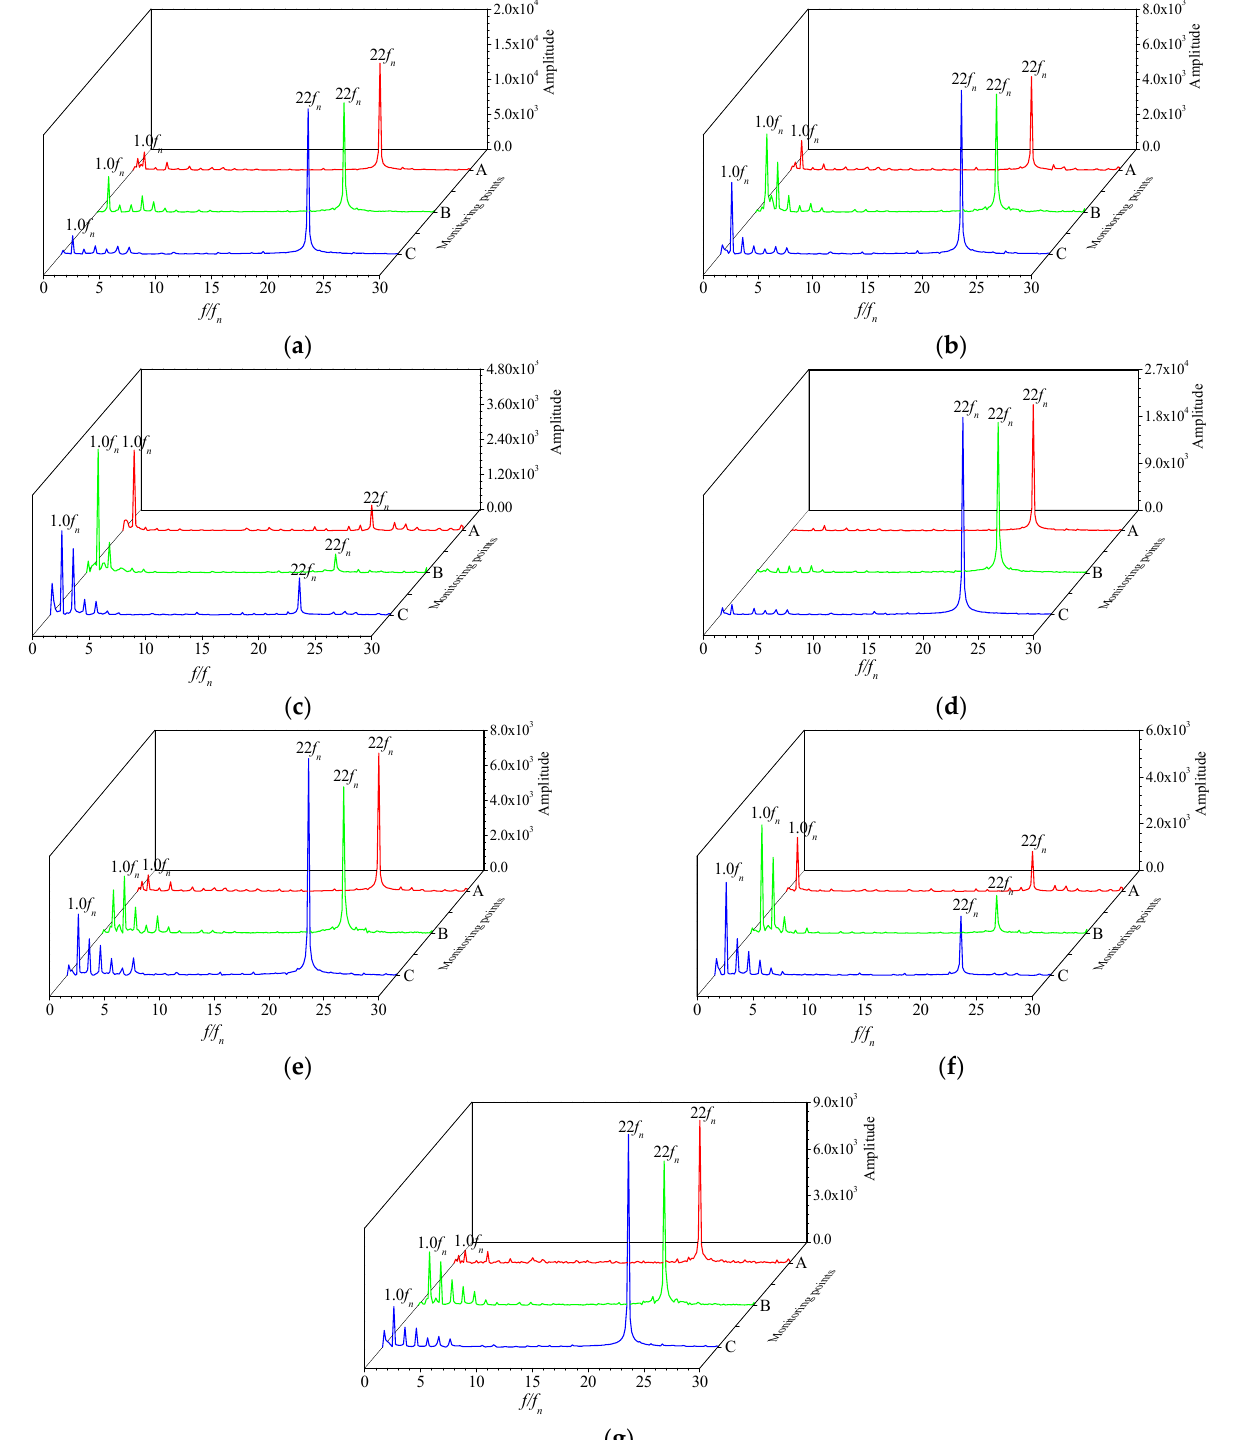
Figure 7. The pressure pulsation of the monitoring point in the runner under different working conditions. ( a ) rn 1 ( b ) rn 2 ( c ) rn 3 ( d ) rn 4 ( e ) rn 5 ( f ) rn 6 ( g ) rn 7